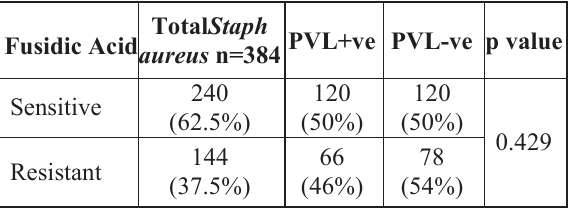
Table-4: Panton Valentine Leucocidin gene and Fusidic